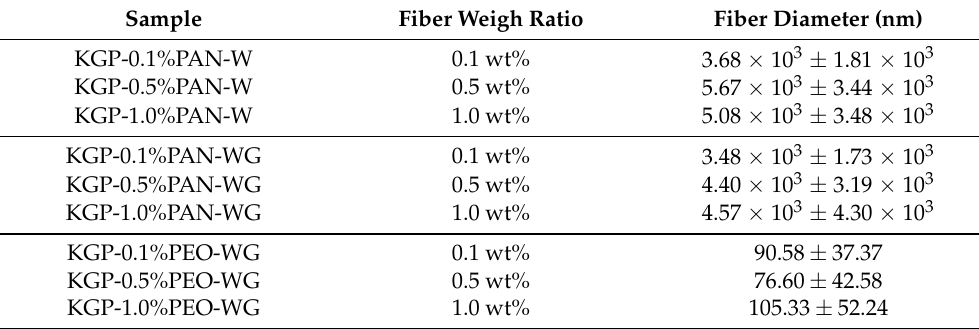
Table 2. SEM image analysis results of Polyacrylonitrile (PAN) and Poly(ethylene oxide) (PEO) electrospun fibers inside geopolymer